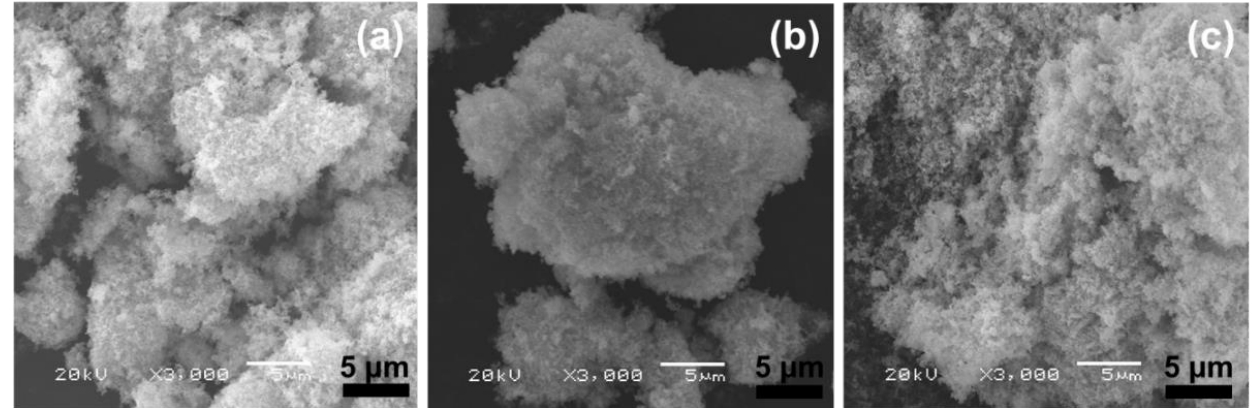
5 of 14 Figure 3. TGA analysis of Cu x Zn y O mixed metal oxide nanoparticles calcined at 350, 450, and 550 °C. 2.3. SEM Analysis The surface morphology of Cu x Zn y O mixed metal oxide nanoparticles calcined at 350, 450, and 550 °C was investigated using an SEM analytical technique. Figure 4 exhibits the SEM images of Cu x Zn y O mixed metal oxide nanoparticles calcined at 350, 450, and 550 °C. An agglomeration of nanoparticles was observed in the materials calcined at three differ-